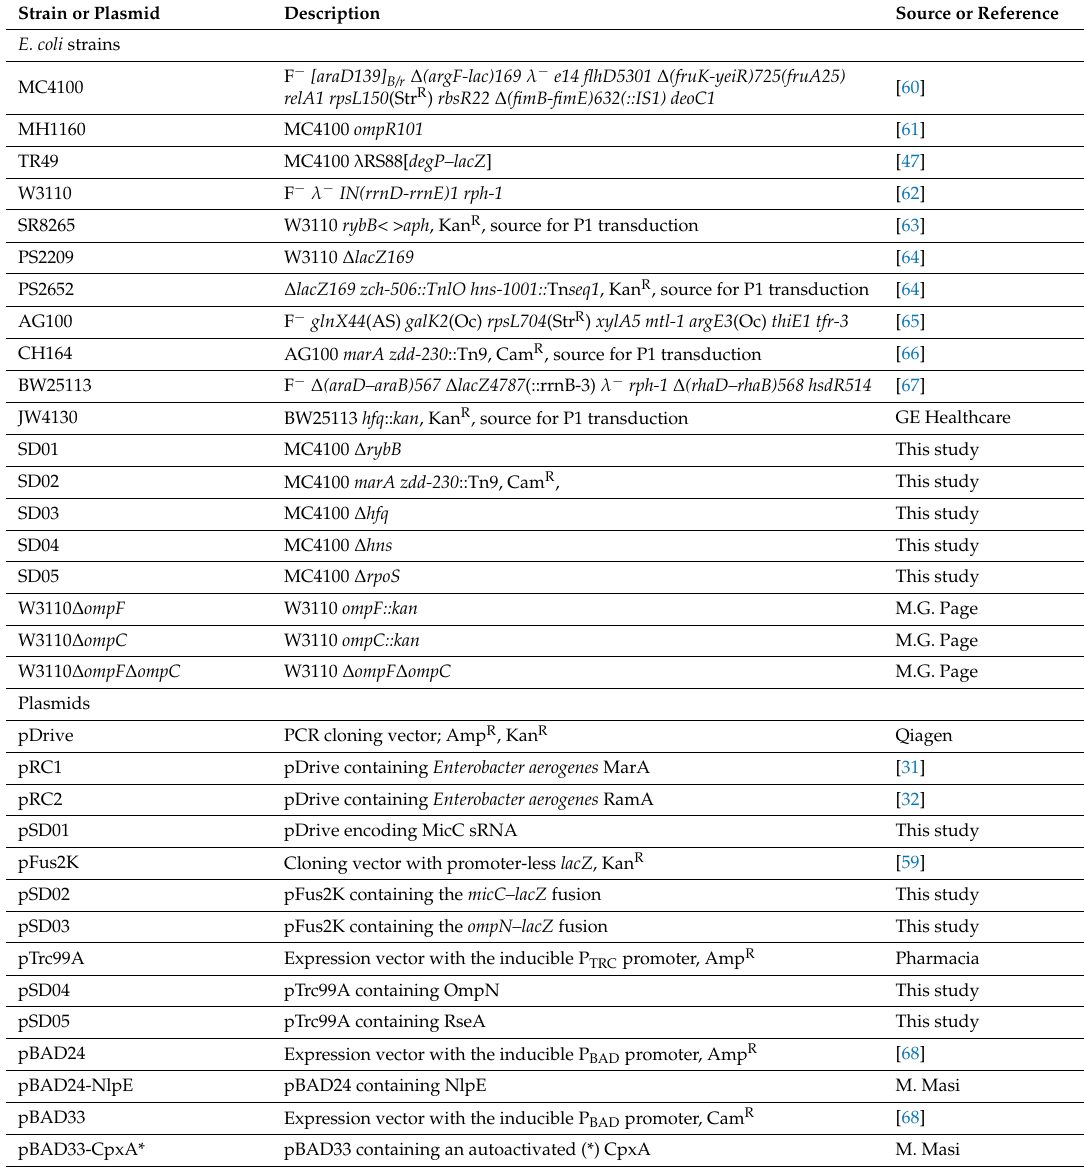
Table 1. Strains and plasmids used in this